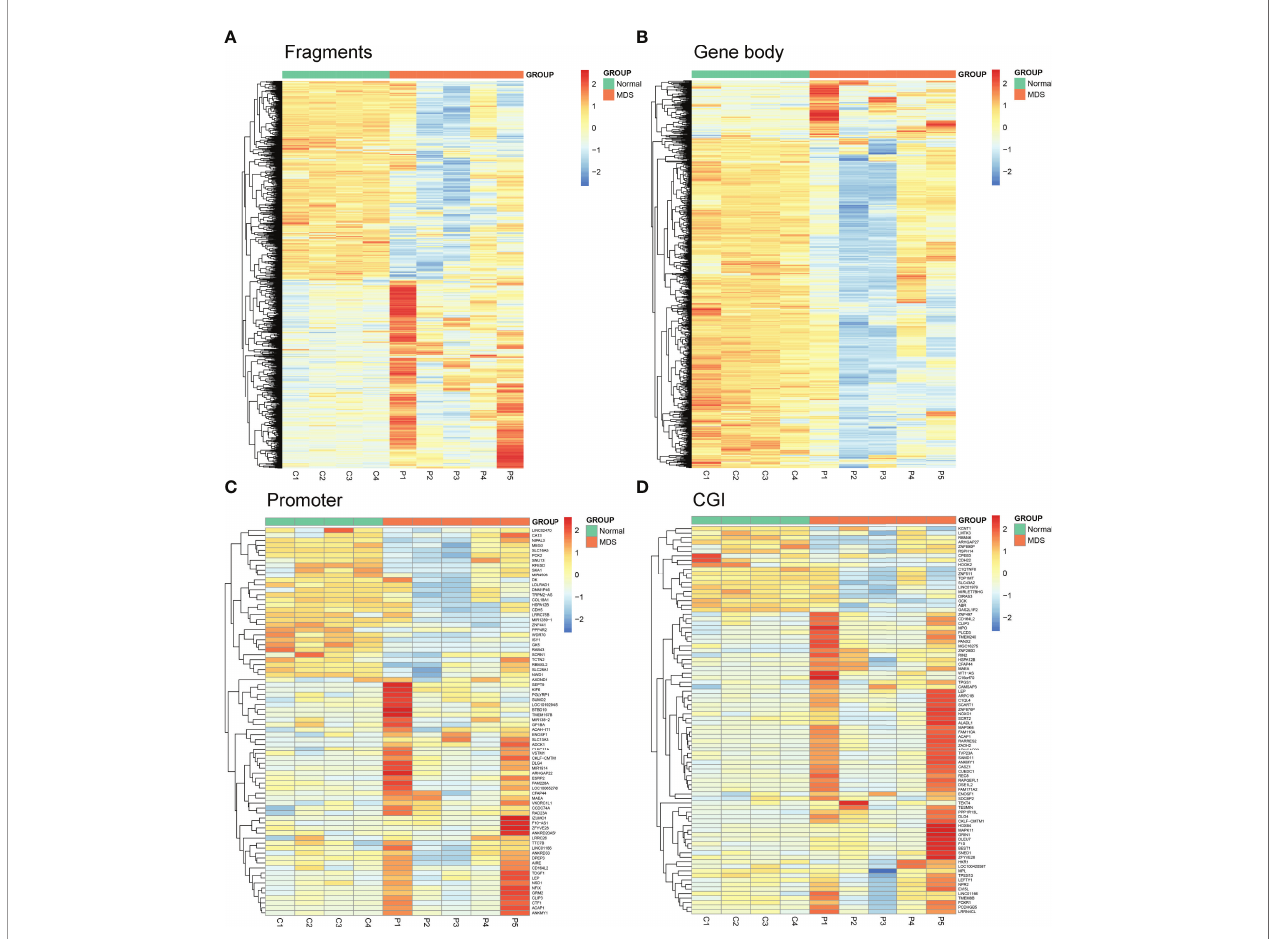
FIGURE 1 | Heatmaps summarizing differentially methylated fragments/genes analyzed by the unit of Mspl fragments, CpG islands, gene body, and promoter. (A) Fragments; (B) Gene Body; (C) Promoter; (D) CGI. The fragments/genes that passed statistical signi fi cance ( P < 0.05, Q < 0.05 and also had > 25% mean methylation difference) were considered as differentially methylated